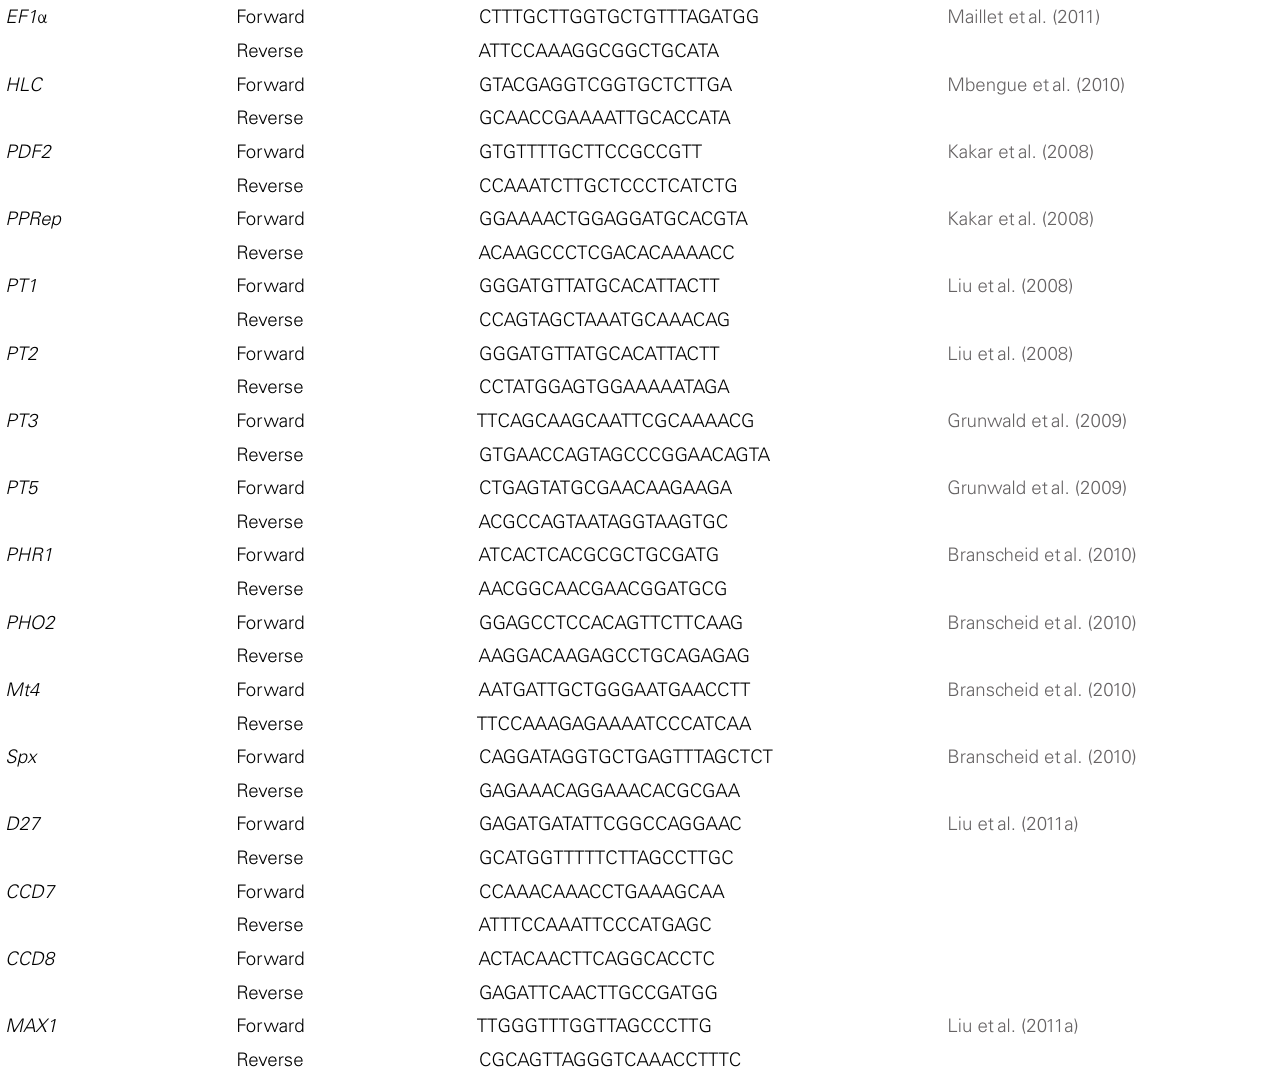
Table 1 | Oligonucleotide